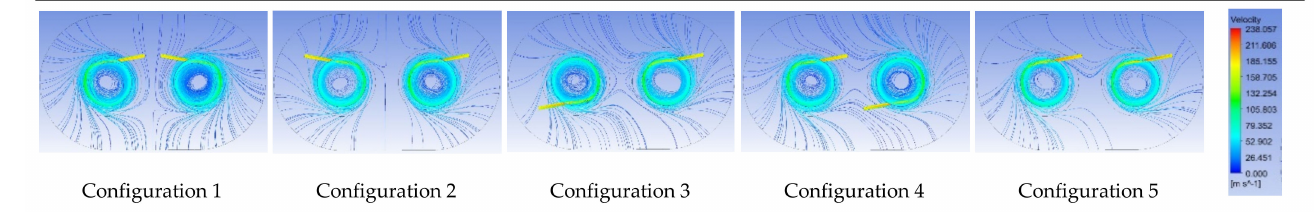
Figure 10. Streamline of dual-vortex grippers (L = 4/3 D 3 ).